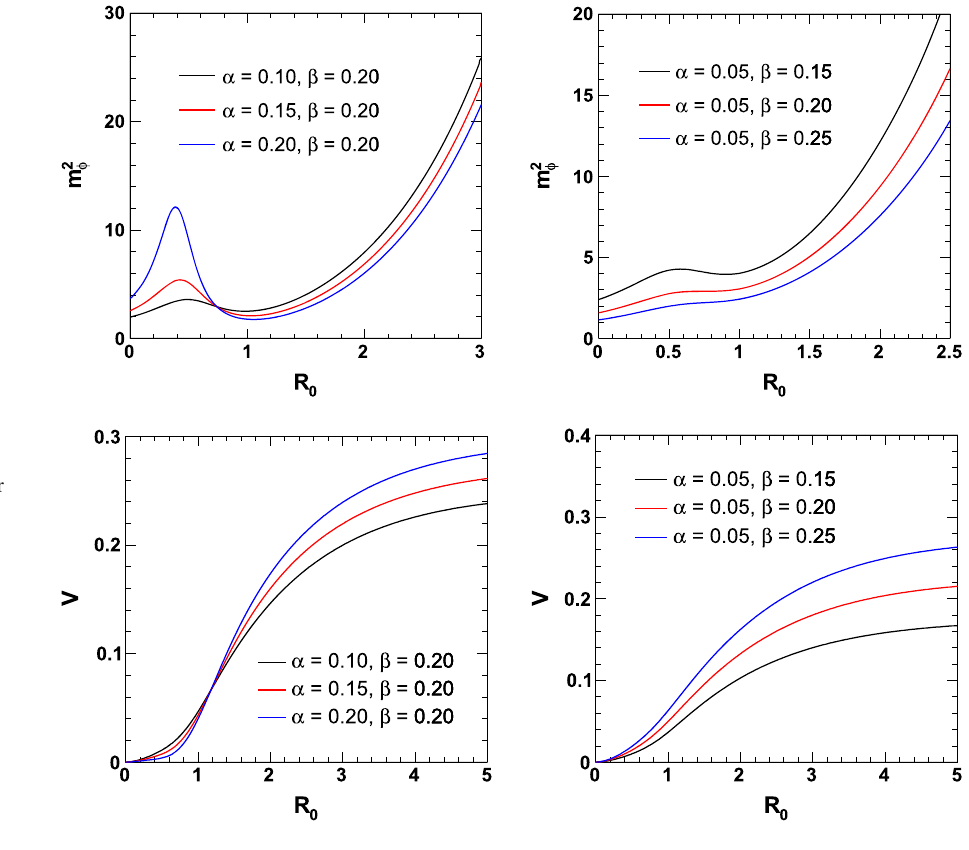
Fig. 1 Mass square of the scalar field as a function of the background curvature for different sets of values of α and β with characteristic curvature constant R c = 1 in arbitrary units